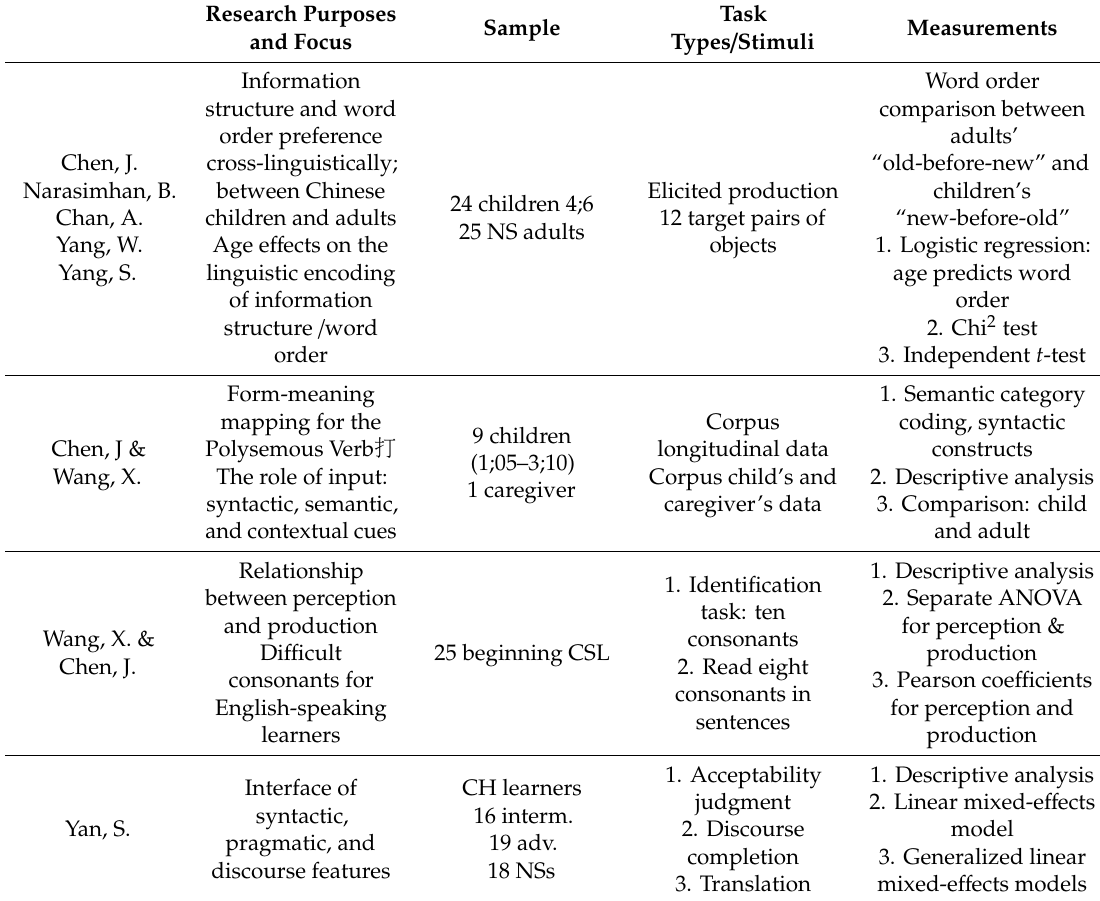
Table 2. Summary of studies on L1 and L2 Chinese acquisition adopting a linguistic